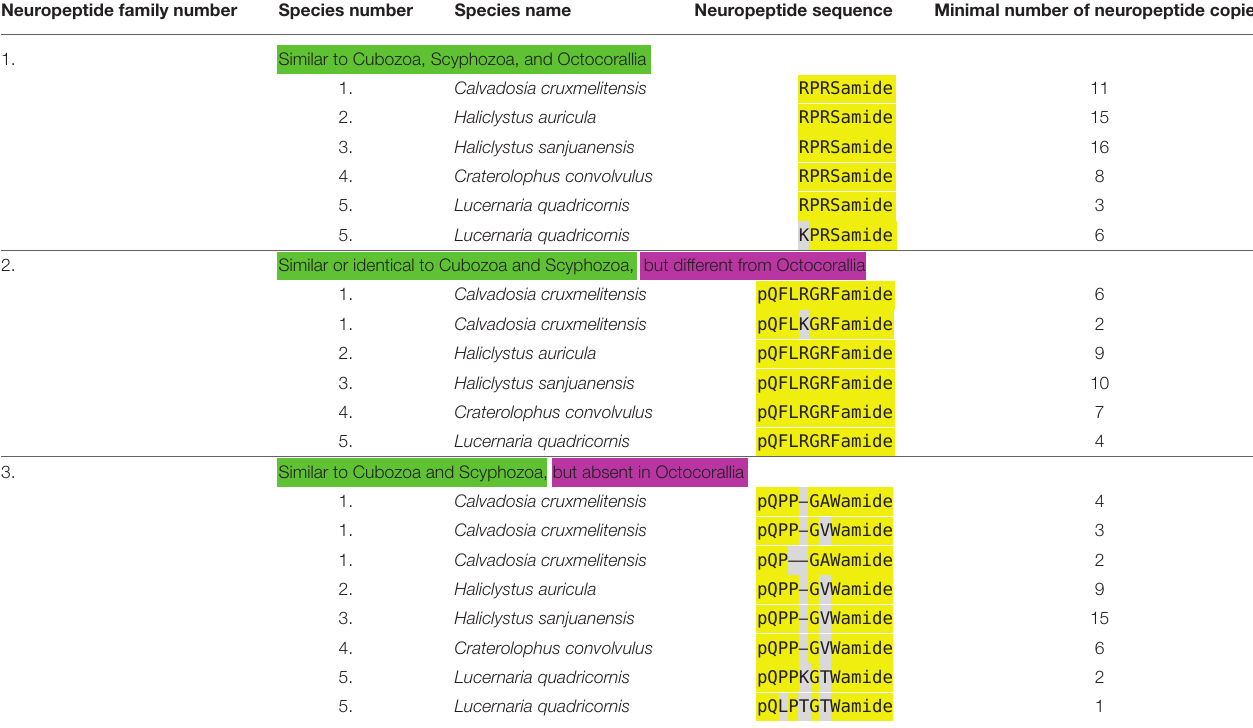
TABLE 3 | An overview of staurozoan neuropeptide